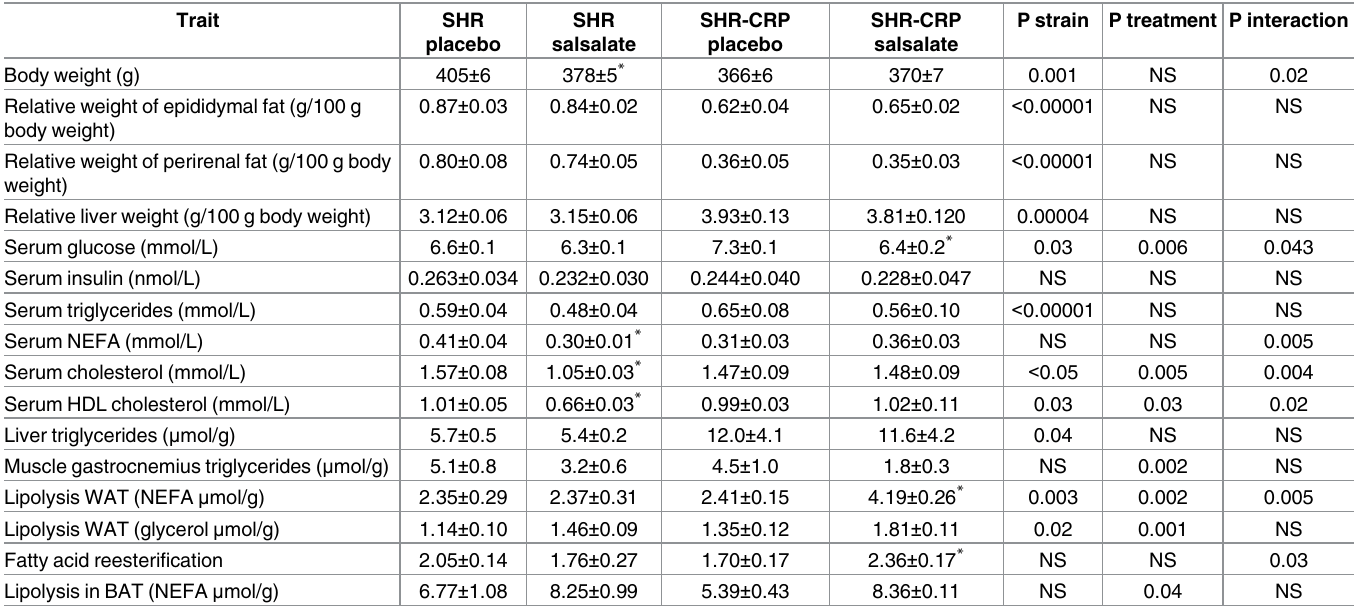
Table 2. Biochemical and metabolic parameters in SHR-CRP transgenic and wild-type controls treated with salsalateor placebo.